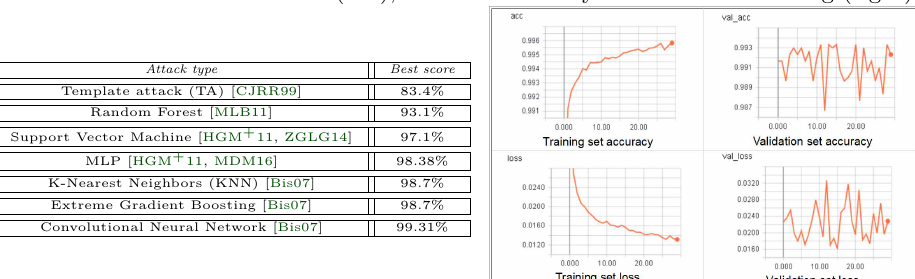
Table 2: Attacks success rates (left), loss and accuracy for the CNN training (right).